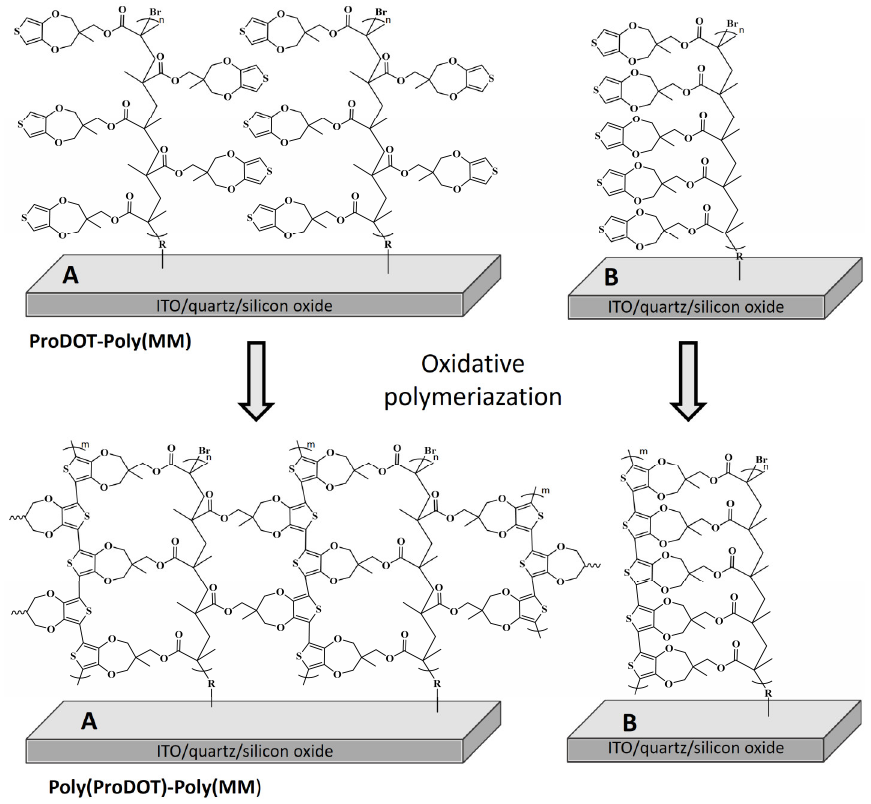
Figure 2. Synthetic route to ladder-like Poly(ProDOT)-Poly(MM) brushes via two reaction path- ways: ( A ) intermolecular linking and ( B ) intramolecular linking of ProDOT groups.